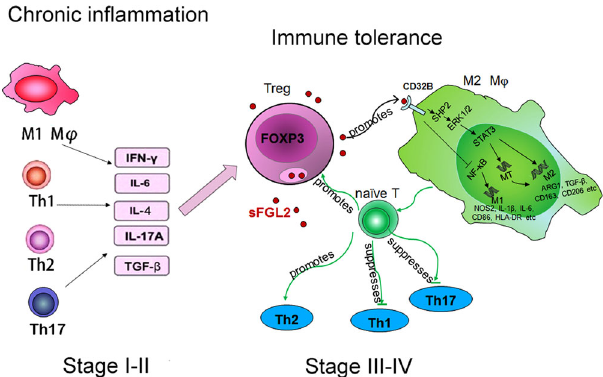
Fig. 10 Schematic diagram of this study. In stage I – II endometriosis, the increased secretion of in fl ammatory cytokines in ectopic milieu induces FGL2 secretion in Tregs. sFGL2 induces pro-repair macrophages skewing through the suppression of NF- κ B and the activation of SHP2-ERK1/2- STAT3 pathway. sFGL2 also up-regulates MT expression in macrophages through STAT3 activation which further promotes pro-repair macrophage polarization. In addition, sFGL2-induced pro-repair macrophages inhibit Th1 and Th17 cell differentiation, while promote Th2 and Tregs differentiation. Taken together, sFGL2 mediated cross-talk between Tregs and macrophage alters the balance of pro- and anti-in fl ammatory microenvironments and facilitates the formation of immune tolerance in stage III-IV